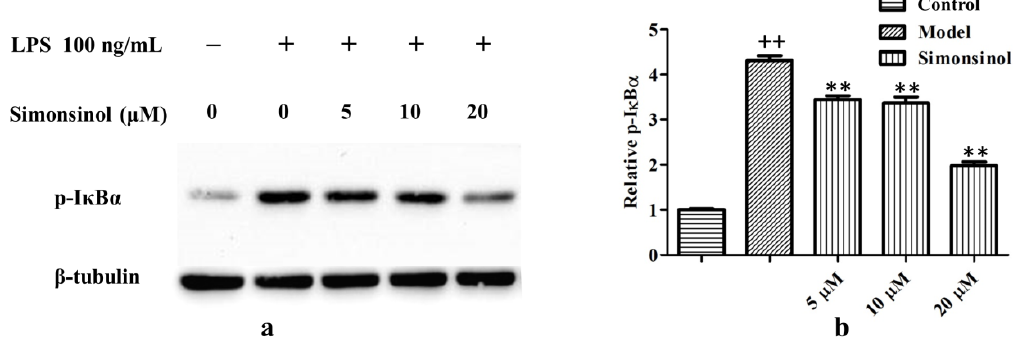
Figure 6. Simonsinol dose dependently suppresses phosphorylation of I κ B α in LPS-induced RAW264.7 cells. ( a ) Representative result of Western blot. ( b ) Relative expression of p-I κ B α . Relative p-I κ B α = (sample intensity of p-I κ B α / sample intensity of p-I κ B α ) / (blank intensity of p-I κ B α / blank intensity of p-I κ B α ). Data are represented as the mean ± SD ( n = 3). ++ , highly significant di ff erence compared to blank control cells ( p < 0.01). **, highly significant di ff erence compared to LPS-stimulated model cells ( p < 0.01).